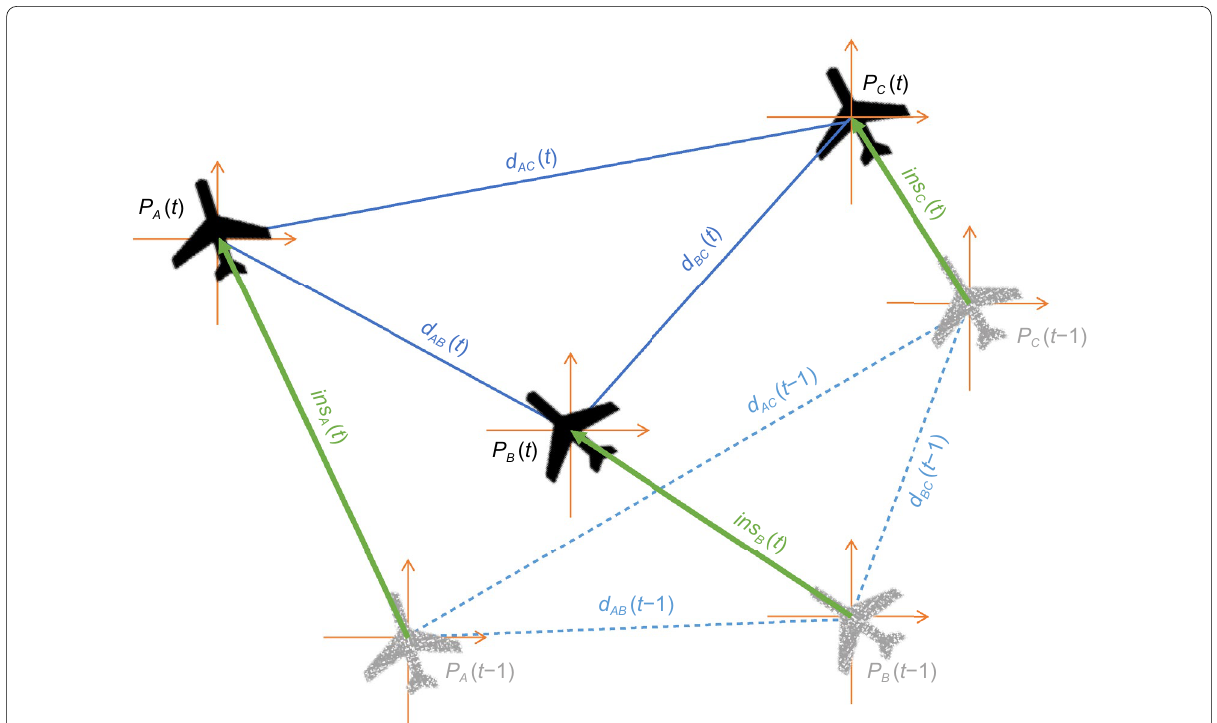
Fig. 2 Observational model of a three-member unmanned cluster